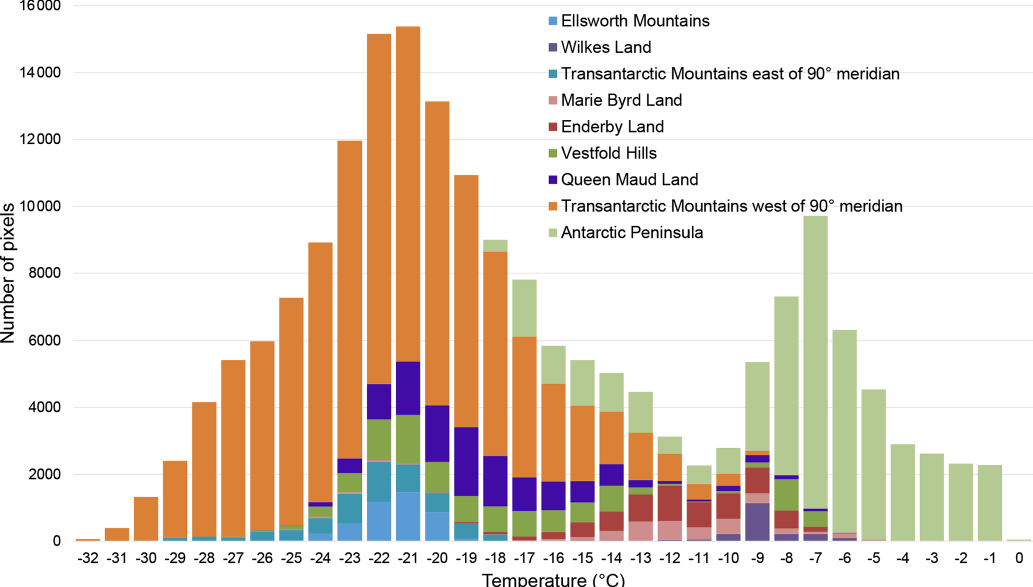
Figure 15. Histogram of temperature distribution across the Antarctic for 1 ◦ C bins. Note: the ice-free areas were often smaller than the analysed pixel size.